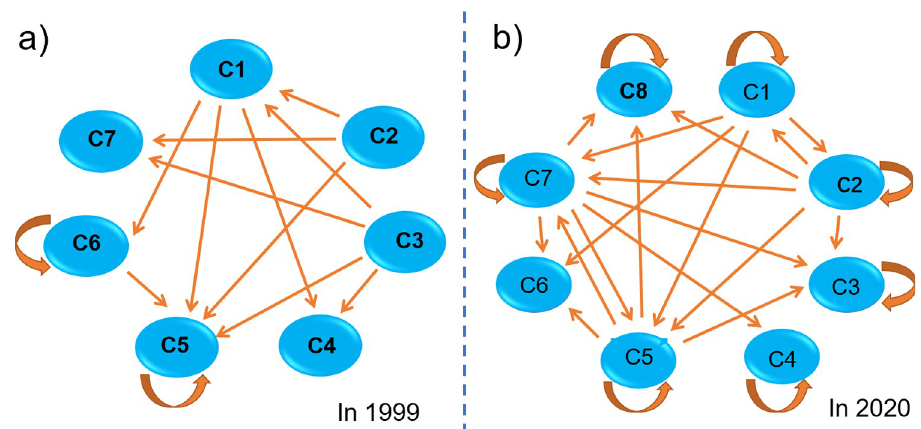
Fig 5. Schematic visualization of cluster modeling for 1999 (a) and 2020